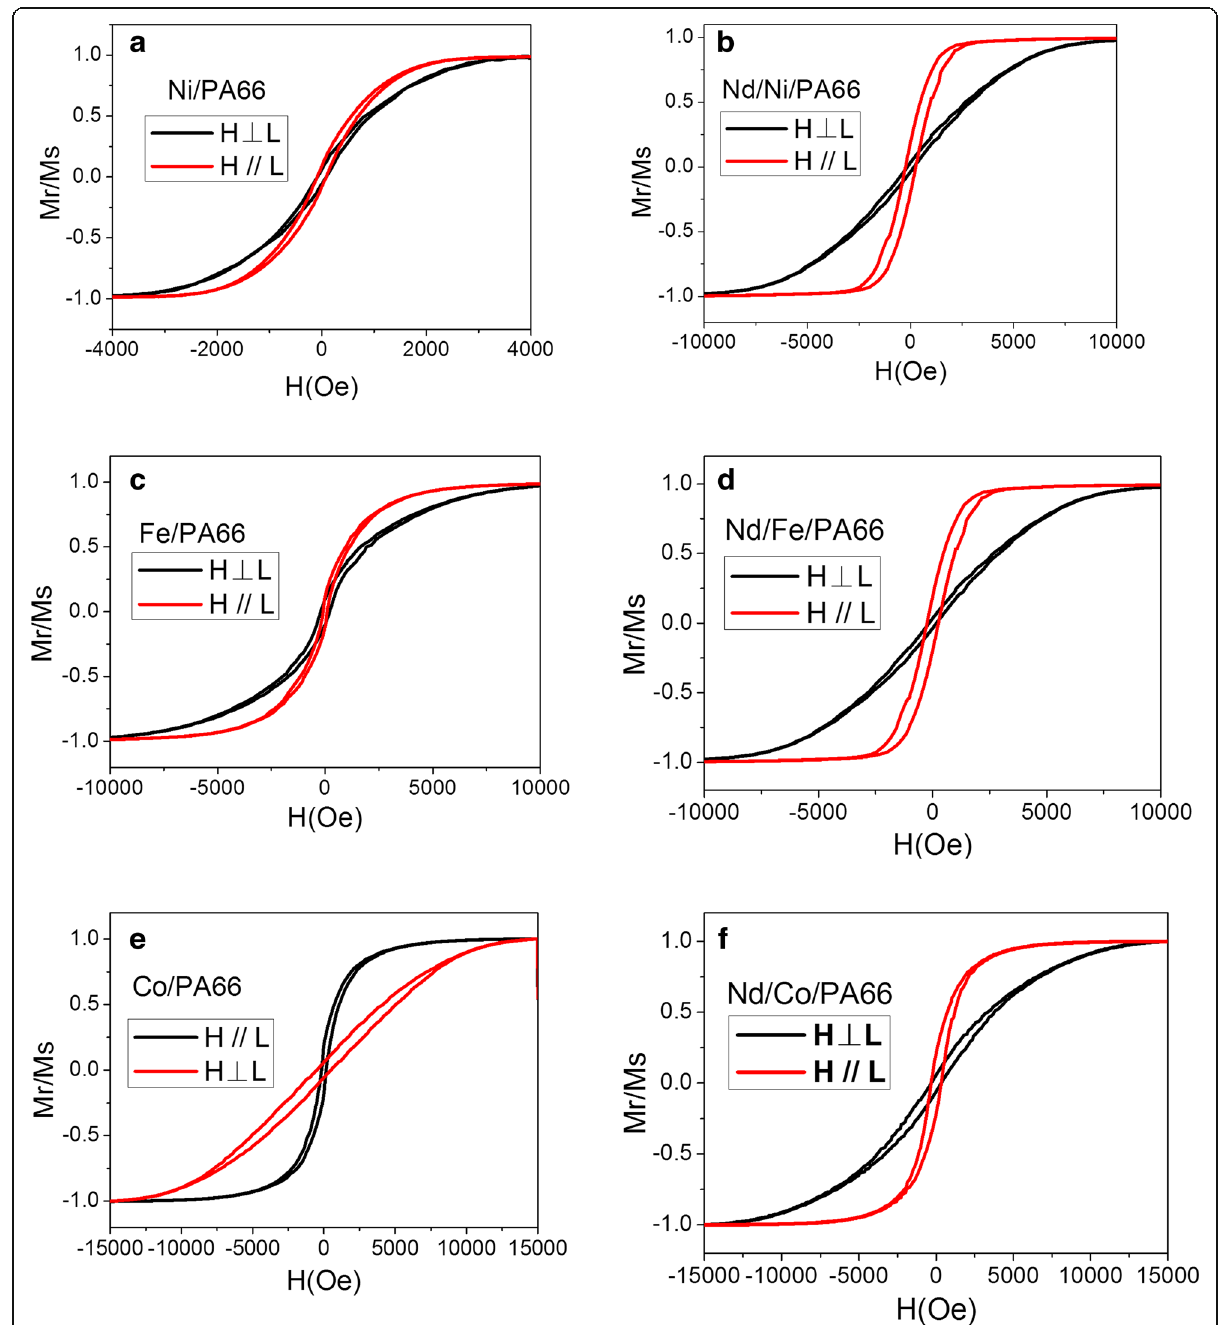
Fig. 5 Hysteresis loops: a Ni/PA66, b Nd/Ni/PA66, c Fe/PA66, d Nd/Fe/PA66, e Co/PA66, and f